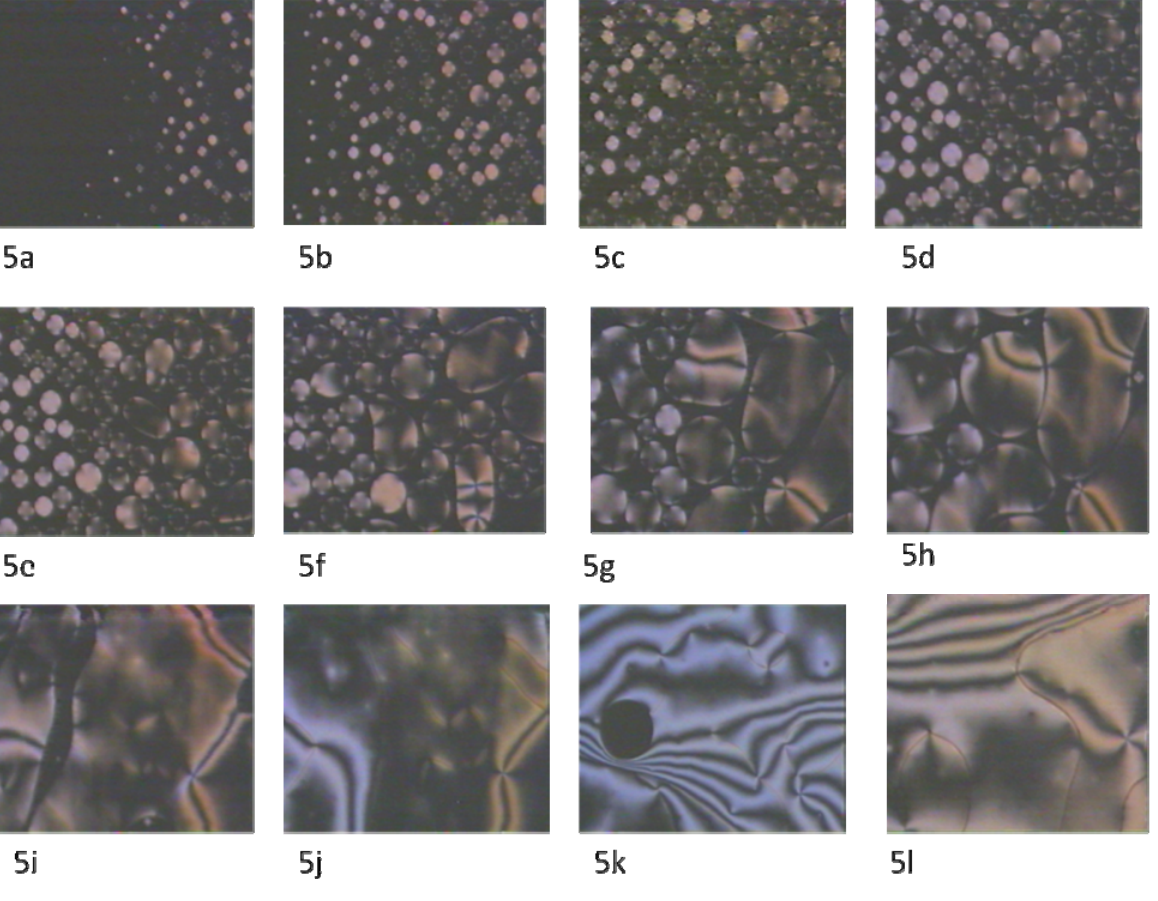
Figure 5. Phase transitions of the monomer upon cooling, cross polarizer, magnification × 150. (5a) Nematic droplets appearing from the isotropic phase with conoscopic crosses; (5b) nematic droplets continue growing at the clearing point with conoscopic crosses, 150 ° C; (5c) nematic droplets are growing with increasing in size and show an optically positive uniaxial behavior, 150 ° C; (5d) nematic droplets starts to coalesce with clear conoscopic crosses, 150 ° C; (5e) coalescence of the crystalline germs,150 ° C; (5f) coalescence of germs in the nematic phase and appearing of points singularities (four- fold brush), 150 ° C; (5g) fourfolds brush defects start to appear, 150 ° C; (5h) coalescence in progress, points of defect increase; 150 ° C; (5i) nematic Schlieren texture grows from coalesced droplets, 150 ° C; (5j) nematic Schlieren texture with four and two brushes, 150 ° C; (5k) nematic Schlieren texture with air bubble, below 150 ° C; (5l) nematic Schleiren texture with four and two brushes upon cooling, below 150 ° C. In Figure 5k, a Schlieren texture with air bubble can be